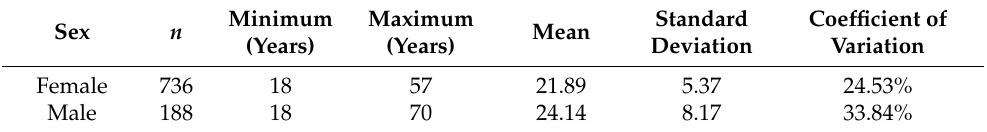
Table 2. Age of the participants according to sex.